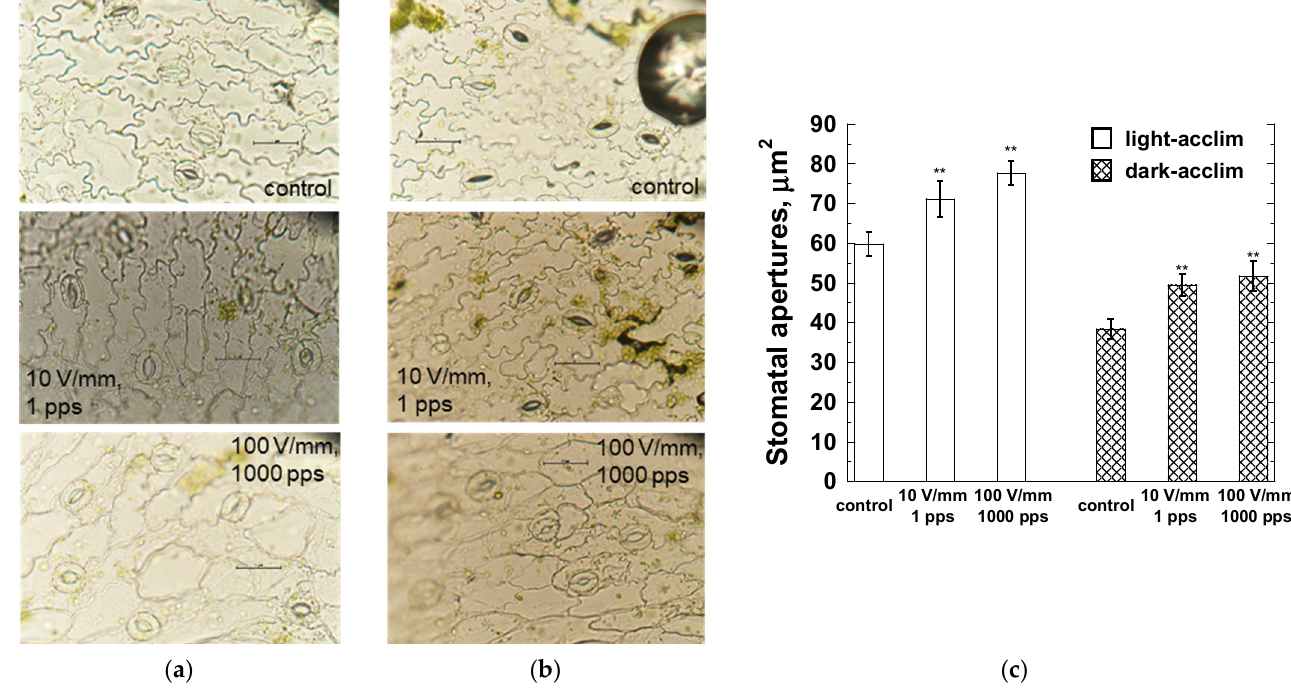
Figure 9. Microscopic images of typical guard cells subjected to varying PEF parameters in stomatal opening experiment. ( a ) Light-acclimated samples, ( b ) dark-acclimated samples. For both light and dark-acclimated samples, PEF application increased stomatal opening compared with the control group. Chart ( c ) shows the areas calculated using ImageJ after tracing the perimeters of the stomatal pores in the microscopic images. Significant increases in stomatal opening due to PEF application were observed in both light- and dark-acclimated samples. The asterisks (**) indicate significant differences at p < 0.01.